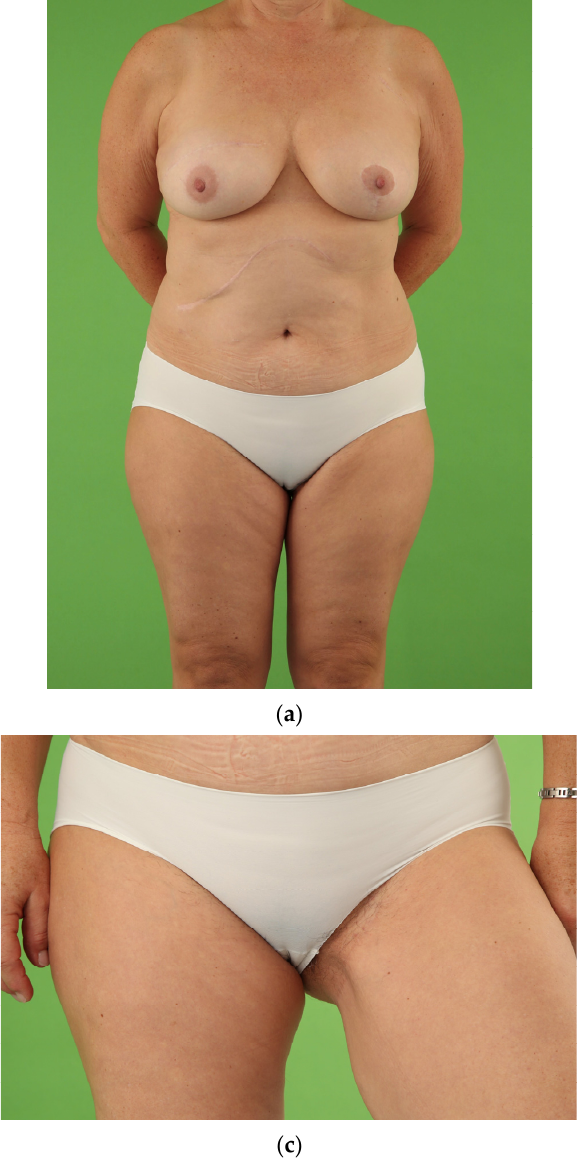
Figure 4. Overweight female patient (59 years, BMI 26.4 kg/m 2 ) with invasive ductal carcinoma of the right breast and partial hepatectomy in the medical history. Salvage reconstruction of the right breast with TMG flap from the left thigh following implant failure after skin-sparing mastectomy and immediate silicone implant reconstruction. Breast reduction with vertical scar of the left breast for symmetrisation. Postoperative view at 5.0 year follow-up. ( a ) Front view with excellent shape and symmetry of both medium size breasts following TMG flap breast reconstruction of the right breast. Natural symmetry of the thighs after unilateral TMG flap harvest with secret scar in the groin of the left donor thigh; ( b ) Back view with secret scar in the natural crease of the left donor thigh; ( c ) Appealing contour of the left donor thigh with concealed scar in the groin.